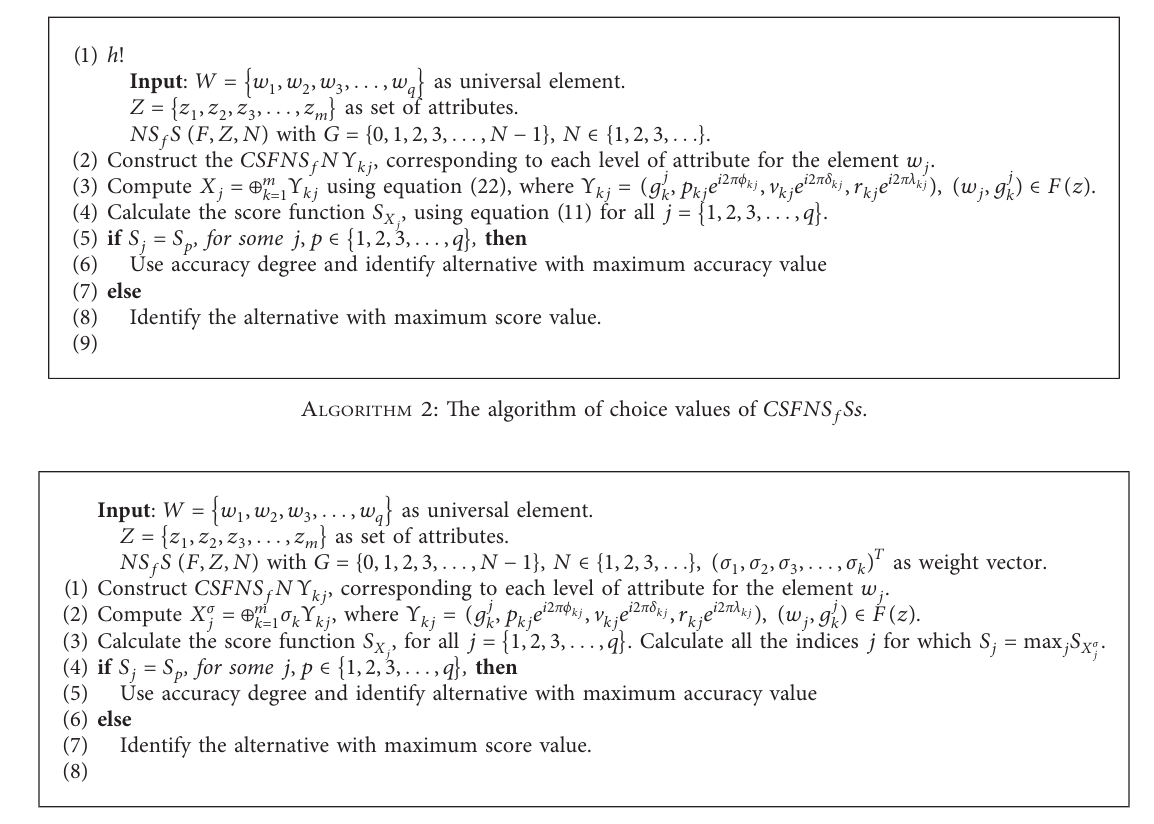
A LGORITHM 3: The algorithm of weighted choice values of CSFNS f Ss .